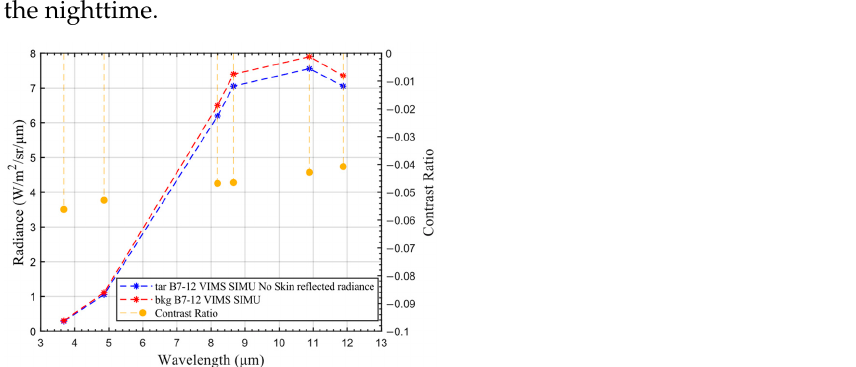
Figure 10. Comparison of target-background contrast ratio in daytime and nighttime. 3.3. Analysis of the Effect of Instrument Performance on Target-Background Contrast The instrument performance is an important factor affecting the aircraft observation characteristics. For space-based observations with long observation distances, unidenti- fied objects, and unpredictable instrument performance in orbit, it is required to examine the effect of instrument performance parameters on the relative differences between the target and background. The impacts of instrument performance parameters such as GSD, MTF, SRF, and NE Δ T on the T-B contrast were analyzed according to imaging time, at- mosphere, and aircraft parameters in the space-based simulation validation session.